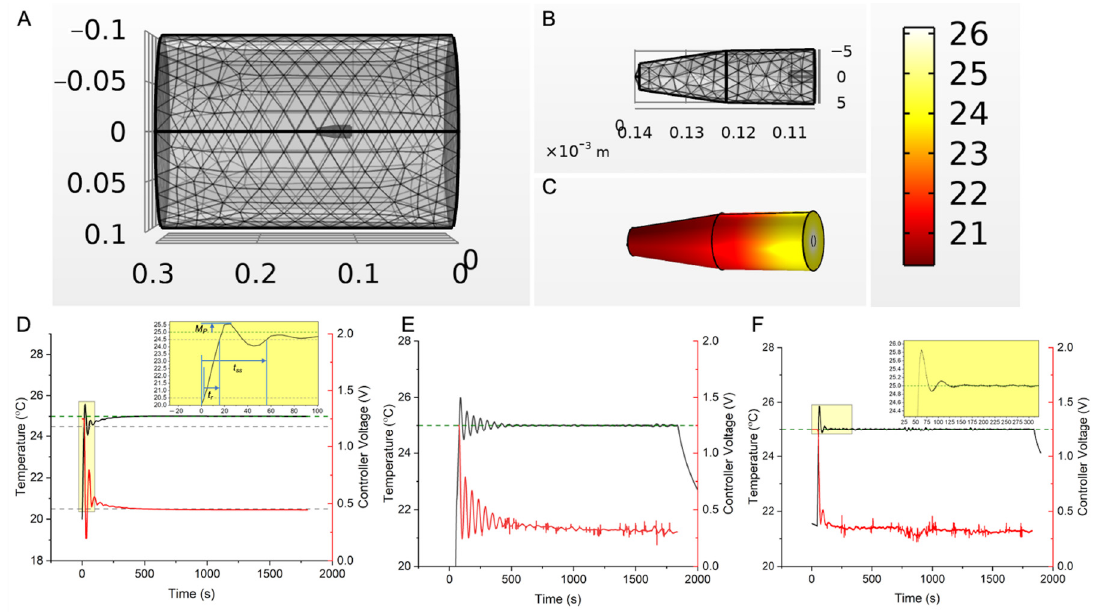
Figure 2. Temperature controller design, simulation, and experimental validation. ( A ) 3D mesh model of the RF coil and gel + Cu wire experimental setup, used to simulate open-loop and closed- loop temperature vs. time responses as a function of AMF and PID gains, through finite element time domain simulations of coupled electromagnetic and heat-transfer equations in COMSOL Mul- tiphysics. ( B ) Zoomed in view of the 3D mesh model of the gel + Cu wire setup shown in ( A ). ( C ) Snapshot of the temperature distribution in the agarose gel + Cu wire system at 30 min, during a PID feedback-controlled simulation of heat transfer, where the setpoint temperature, T ref , at the probe location (2.3 mm from center) was set to 25 ◦ C. ( D ) Simulated temperature vs. time responses (black curve) for setup in ( C ), for input gains ( K p , K i , K d ) of ( 0.26 , 0.001 , 3 ). Response curves to different input gains ( K p , K i , K d ) in the neighborhood of calculated gain values ( 0.26 , 0.001 , 0.11 ) are shown in Figure S1 ( 0.26 , 0.001 , 𝐾 (cid:3031) ), where 2 < 𝐾 (cid:3031) < 3, was chosen as initial gains (starting with 𝐾 (cid:3031) = 3) for the experimental system to ensure a quick rise time. The red curve and right-axis repre- sent controller feedback voltage. A 0–1.25 V range correspond to 0–9.8 kA/m peak AMF amplitude at 160 kHz. Inset shows rise time ( t r ), settling time ( t ss ), and overshoot ( M p ). ( E ) Experimentally meas- ured temperature vs. time response (black curve) in the agarose gel + Cu wire system, during a 30 min PID temperature-control experiment, where the setpoint temperature, 𝑇 (cid:3045)(cid:3032)(cid:3033) , was input as 25 °C. Initial gains of ( 0.2 , 0.001 , 3 ), similar to the model, were entered, but integral gain , 𝐾 (cid:3036) , was lowered to lower the effect of integral-windup and consequent power supply tripping from rapid oscilla- tions. Final gains that resulted in a stable compromise between rise time, settling time and minimiz- ing power oscillations, were ( 0.23 , 0.0001 , 2.84 ). The red curve and right-axis represent controller feedback voltage. A 0–1.25 V range correspond to 0- 9.8 kA/m peak AMF amplitude at 160 kHz. ( F ) Experimentally measured temperature vs. time response (black curve) in the “tuned” agarose gel + Cu wire system, during a 30 min PID temperature-control experiment, where the setpoint temper- ature, 𝑇 (cid:3045)(cid:3032)(cid:3033) , was input as 25 °C and gains of ( 0.23 , 0.0001 , 2.84 ) were used. Inset shows the initial overshoot < 5%. Settling time ( 𝑡 (cid:3046)(cid:3046) ) of 39.7 s and rise time ( 𝑡 (cid:3045) ) of 8.35 s were observed, well within the design specifications of the control system ( 𝑡 (cid:3046)(cid:3046) < 5 min, 𝑡 (cid:3045) < 60 s). The red curve and right-axis rep- resent controller feedback voltage. A 0–1.25 V range correspond to 0–9.8 kA/m peak AMF amplitude at 160 kHz. In vitro experiments for validation of controller temperature response were conducted three times (N = 3). These performance criteria can be equivalently achieved for MNPs if the total power deposited by the MNPs is the same per unit volume, under the same AMF amplitude and frequency, i.e.,